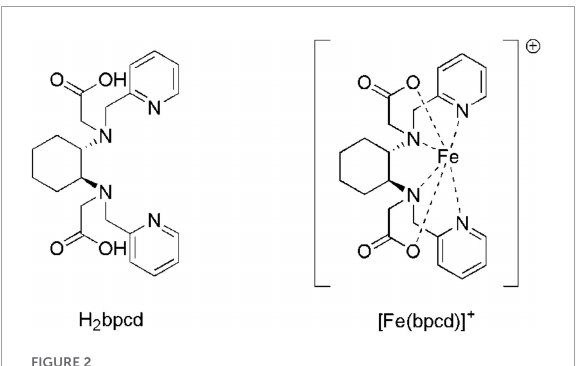
FIGURE2 Molecular structures of H 2 bpcd and [Fe(bpcd)] + , the molecules synthesized and discussed in the present contribution. The racemic form of the ligand has been